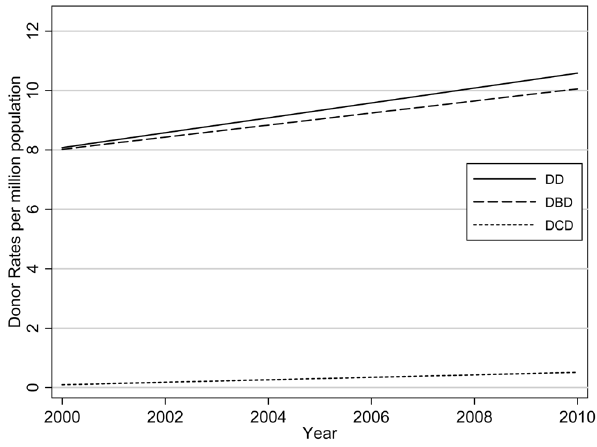
Figure 1. Overall average Deceased Donors (DD), Donation after Brain Death (DBD) and Donation after Cardiocirculatory Death (DCD) rates over time. Averages have been calculated from a linear mixed model, with random intercept and slope for country.